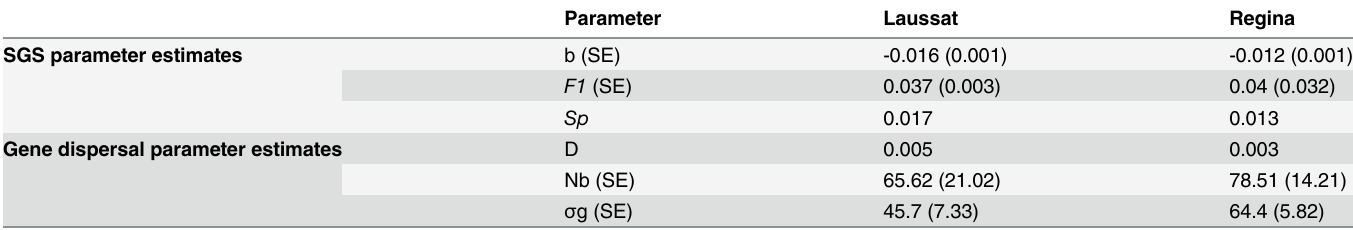
Table 2. SGS and gene dispersal parameters estimated by